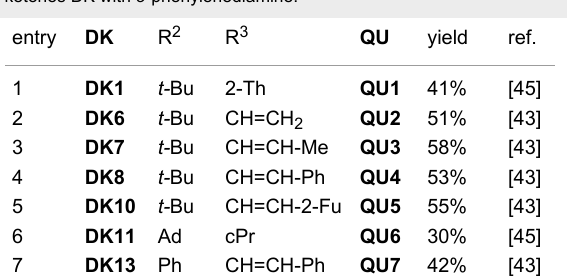
Table 7: Preparation of quinoxalines QU1 – 7 by condensation of 1,2-di- ketones DK with o -phenylenediamine.